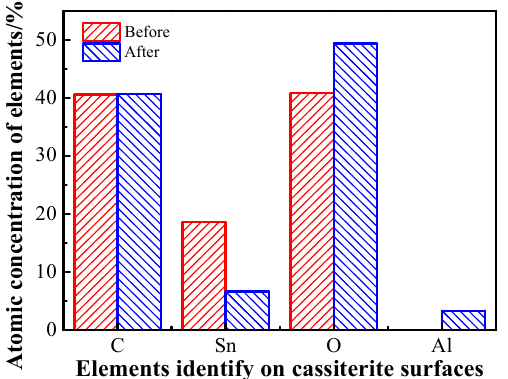
Elements identify on cassiterite surfaces